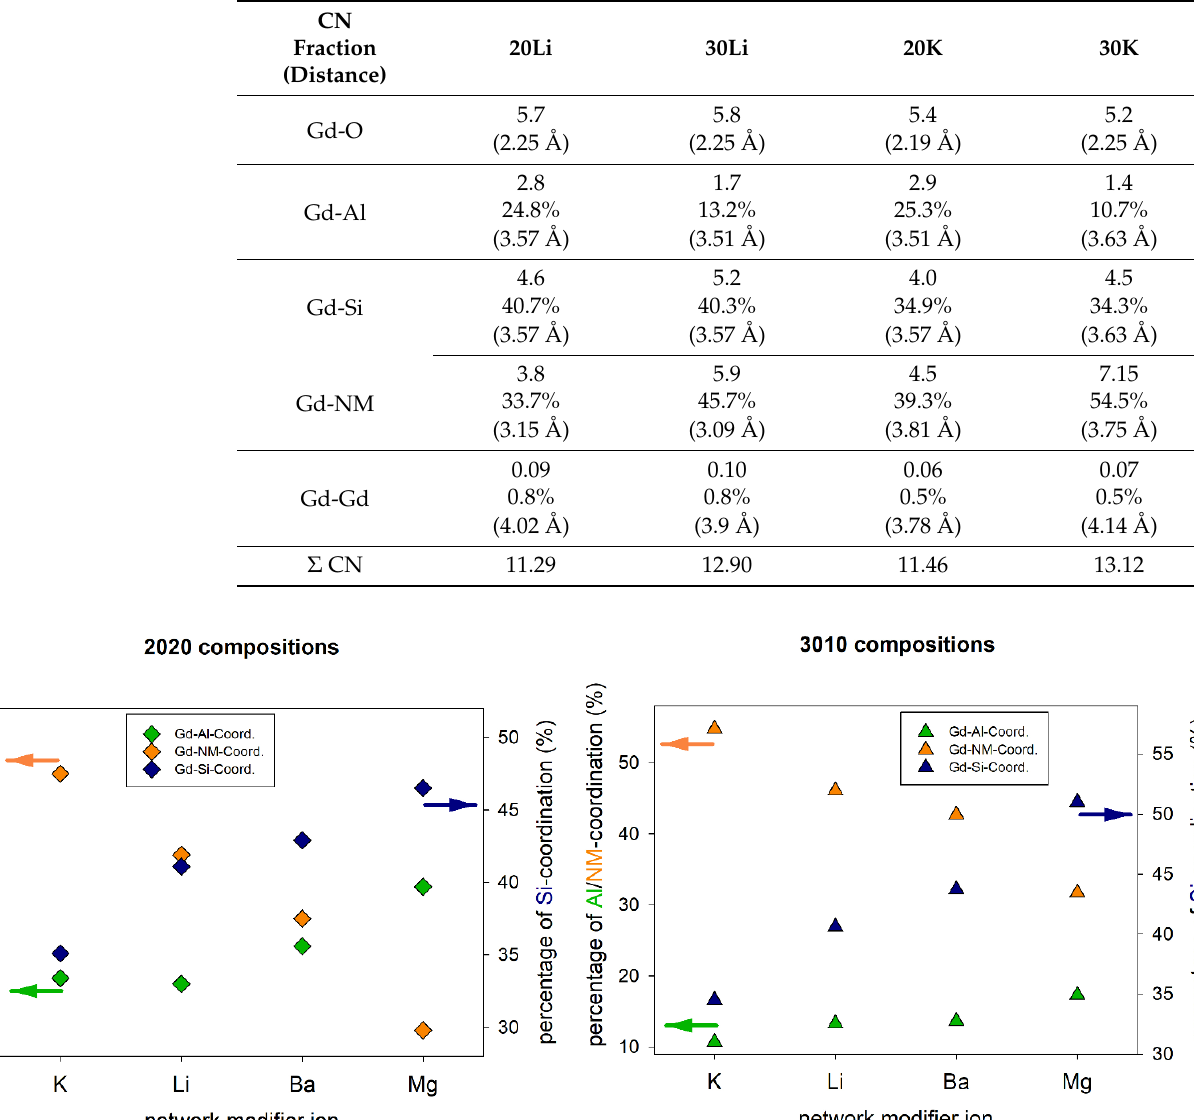
Table 7. Coordination numbers (CN) and interatomic distances of the Gd 3+ ions in the first coordina- tion shell (oxygen) and the second coordination shell obtained for different chemical compositions.